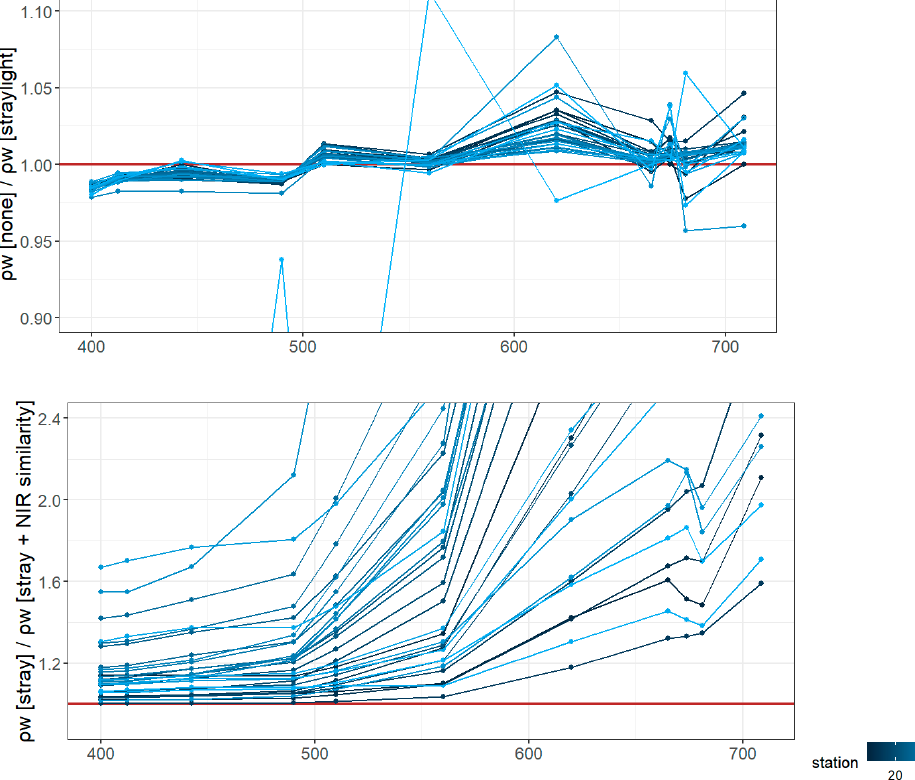
Figure 7. The ratio of uncorrected to straylight corrected ρ w (above) and straylight corrected to straylight and NIR similarity corrected ρ w (below) over all stations. Brown line is set to 1 to show the direction of the